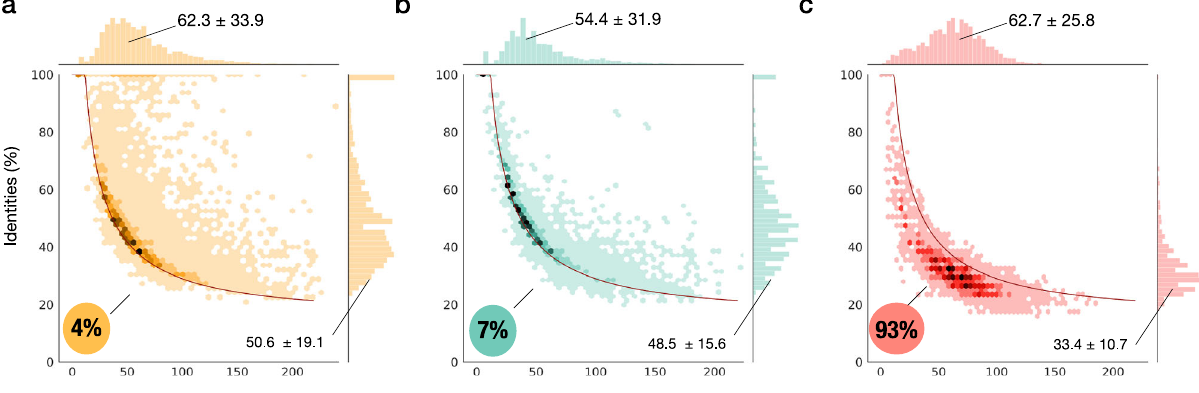
Fig. 2 | Pairwise sequence identities vs. alignment length for each of the data- sets (a: natural (yellow), b: ProtGPT2 (green), and c: random (red)) as com- putedwithHHblitsagainsttheUniclust30database. Thelinesdepictedinredon each plot represent the HSSP curve, which we use as a reference to compare the three datasets 40 . Each plot shows a hexbin compartmentalization of the best-